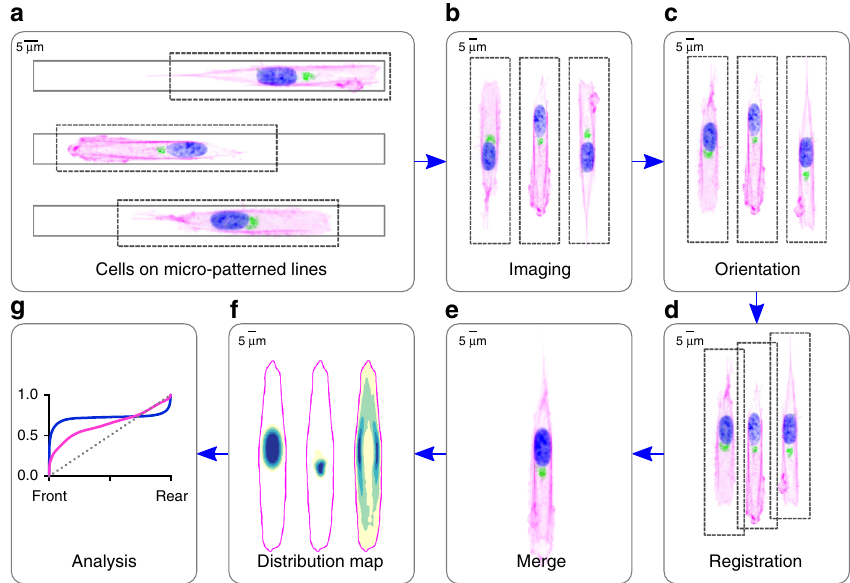
Fig. 1 Distribution map preparation scheme. a Representative cells migrating on micro-patterned lines. b Random images of single cells. c Orientation of single cells using Golgi signal as a marker of directionality d Nuclei registration. e Merged image of multiple cells from the dataset. f Color-coded distribution maps of the nucleus, Golgi and actin. g Normalized density plot of the front-to-rear